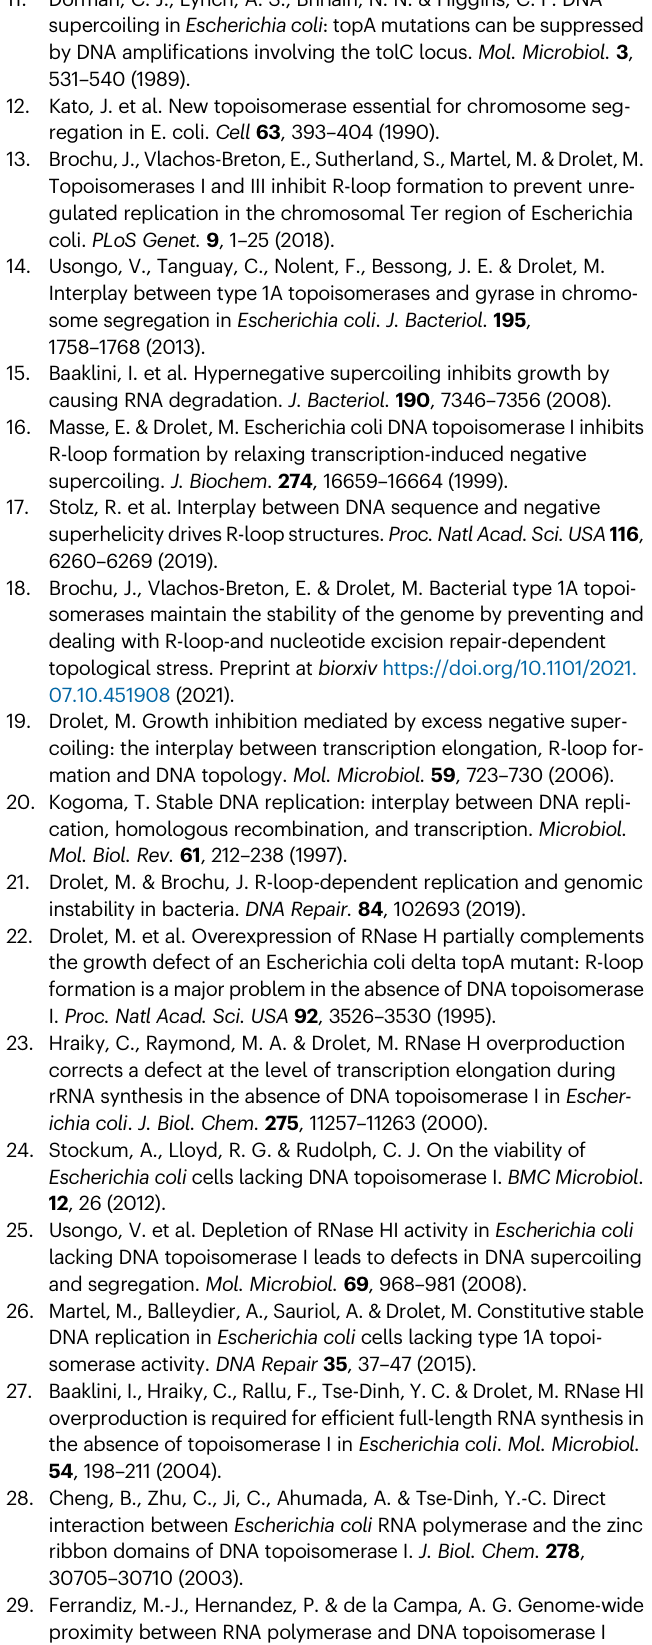
Supplementary Table 2. E. coli W3110 genome annotations with ORFs, operons,andTUswereobtainedfromEnsemblBacteria 90 ,DOOR 91 ,and EcoCyc 92 databases, respectively. Information about the subcellular localization of E. coli proteins was retrieved from PSORTdb 4.0 93 . Annotations ofpromotersand transcription factor sites wereobtained from RegulonDB 94 . Source data are provided with this